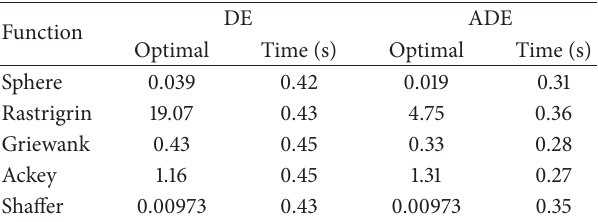
Figure 1: Flow chart of difference evaluation algorithm.